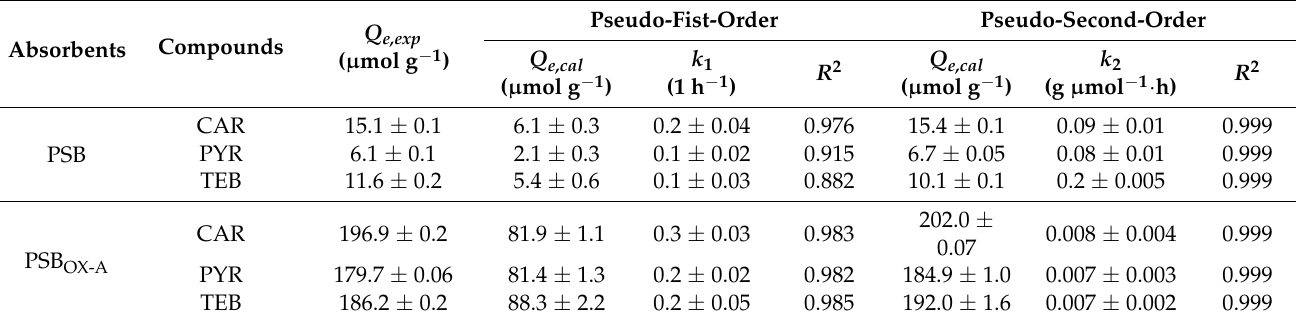
Table 3. Kinetic parameters for the adsorptions of the selected fungicides using PSB and PSB OX-A (agitation speed = 150 rpm; contact time = 24 h; absorbent dosage = 50 mg L − 1 ; initial concentration of each fungicide = 10 µ M; temperature = 25 ◦ C; pH = 7.0).